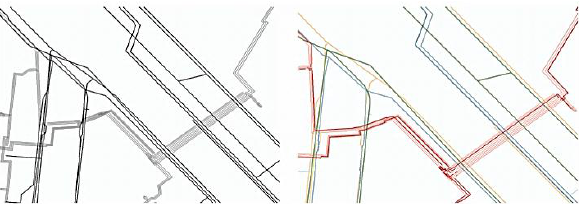
Figure 2. Cartographic Representation of multiple utility networks - uniformly (left) and systematically colorized (right) according to (RAL, 2001) A starting point for the visual differentiation of utility networks is colorization – used to represent the transported commodity type, and thickness – used to represent the network hierarchy. In particular the colour is widely used to encode distinct information - their usage is seen to be critical due to their strong influence on human’s perception and cognitive load (Steinrücken, 2009; Bertin and Berg, 1983). Uniform portrayals, as shown in Figure 2 (left), prevent the perception of commodity types, whereas Figure 2 (right) enables the identification of different network hierarchies (red lines) and the network affiliation (yellow = gas, green = wastewater, blue = freshwater, red = district heat).